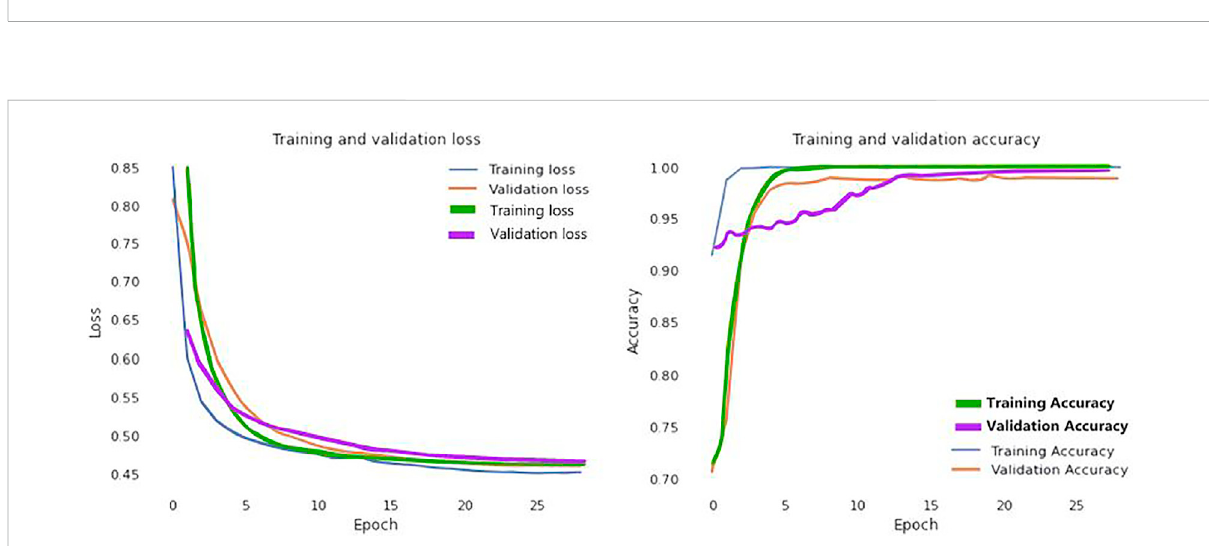
FIGURE 6 Loss and accuracy curves of the proposed model (Blue and yellow curves represents for CT scan images; green and purple curves ensembles for the X-Ray images).